Question: Does the plotted quantity increase or decrease?
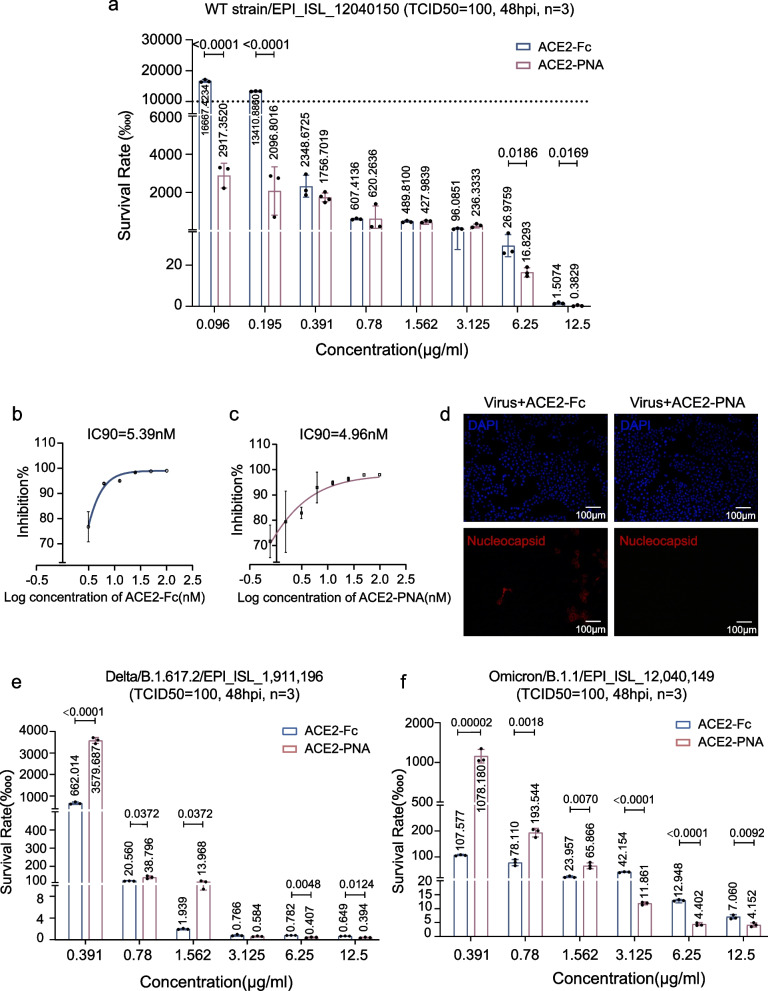
Answer: increasing